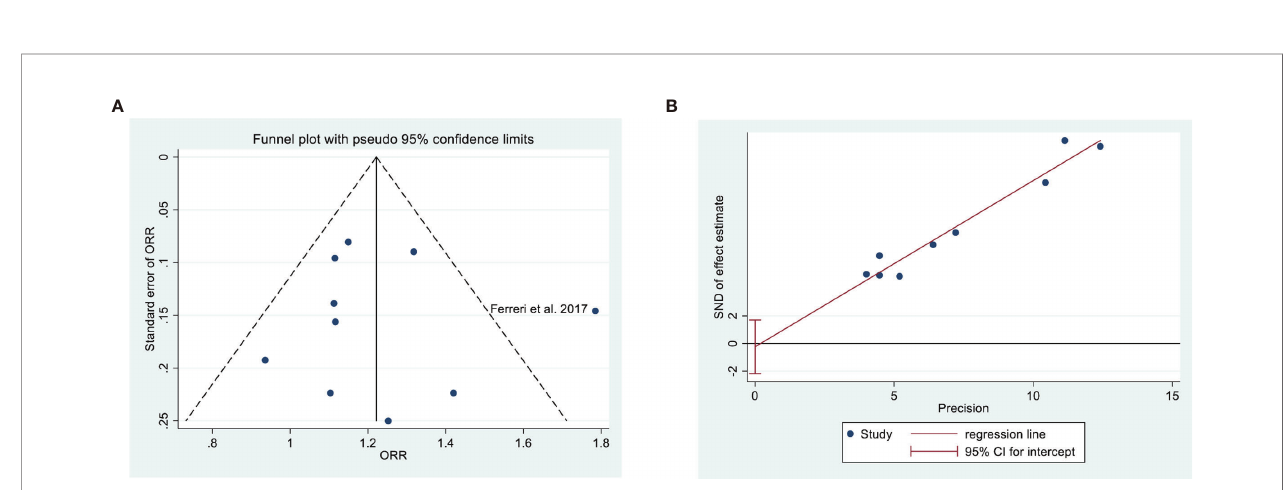
FIGURE 3 | Subgroup analysis of overall response rates of patients with germinal center B-cell-like (GCB) phenotype or non-GCB phenotype who received maintenance treatment consisting of lenalidomide monotherapy.